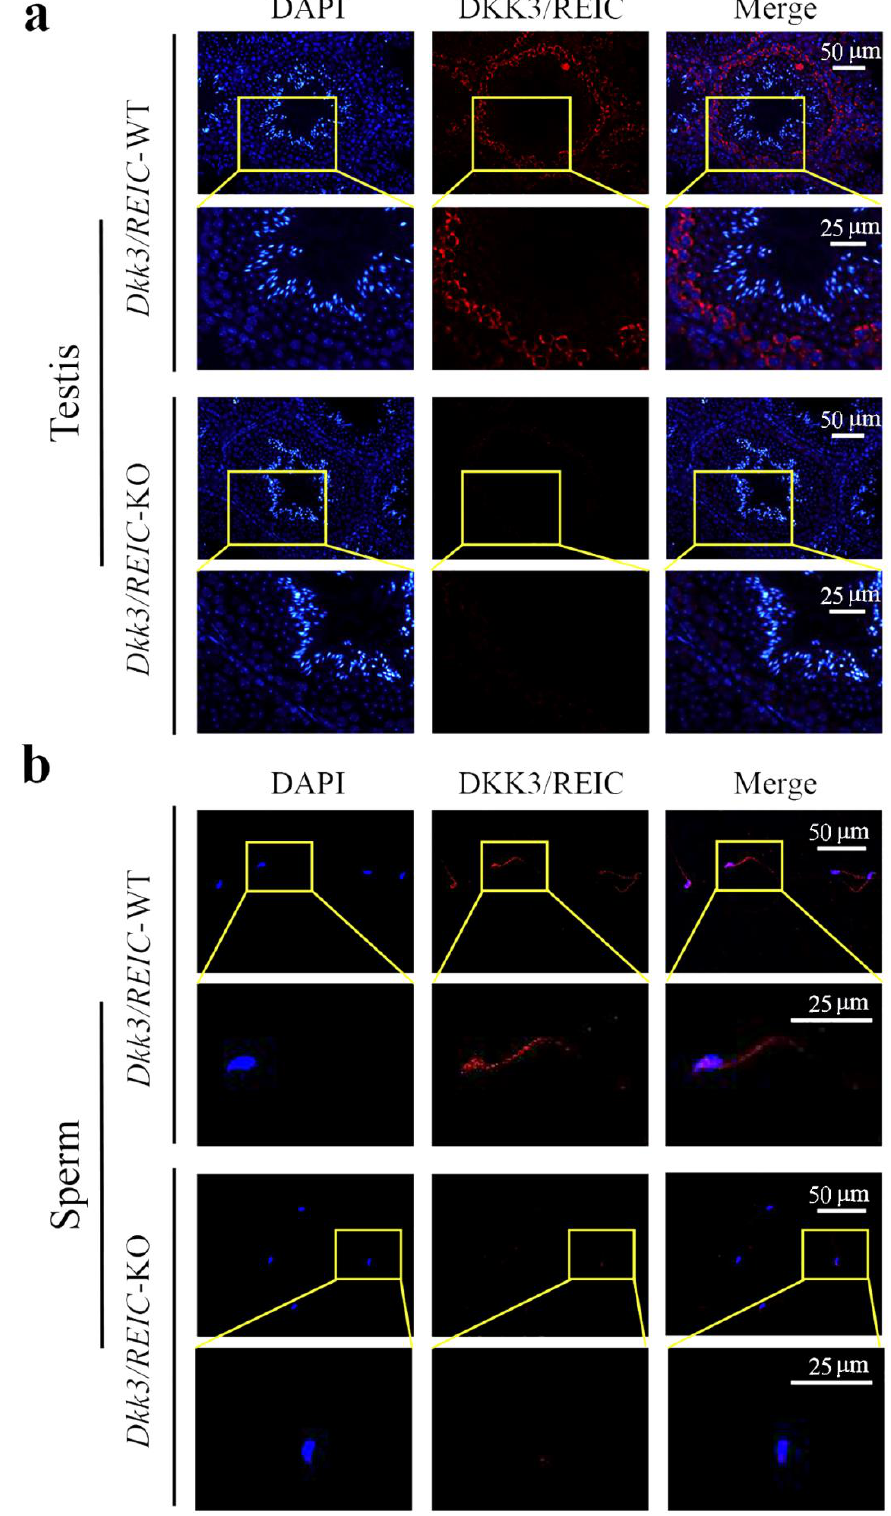
Figure 3. Expression and localization of DKK3/REIC protein in mouse seminiferous tubules and sperm. The expression and distribution of DKK3/REIC protein in ( a ) testes and ( b ) sperm of Dkk3/REIC -WT and Dkk3/REIC-KO mice.